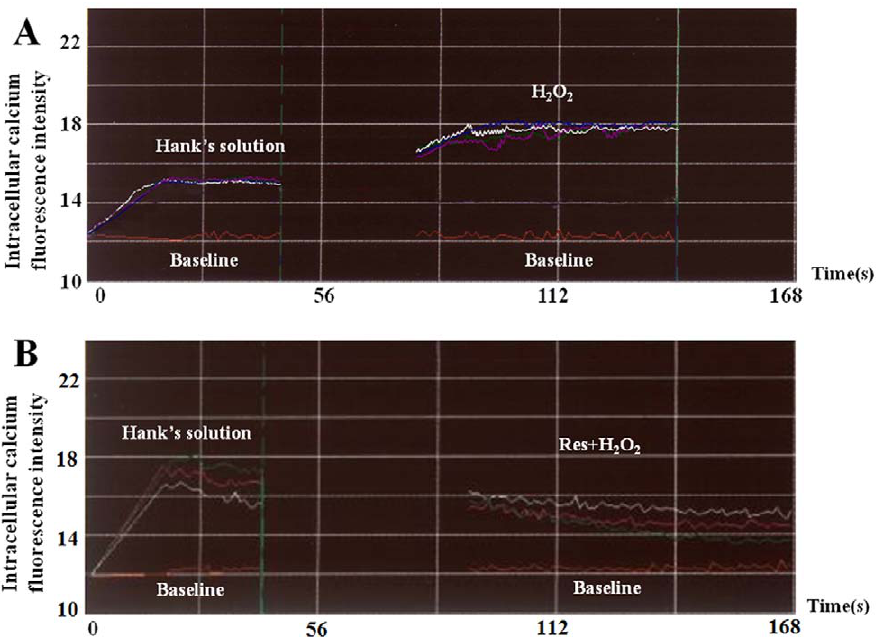
Figure 7. Effect of Res on the elevated intracellular calcium induced by H 2 O 2 . (A) In Hank’s solution, H 2 O 2 led to the increase of intracellular calcium, and the fluorescence intensity increased. (B) In Res group, the effect of H 2 O 2 was abolished by